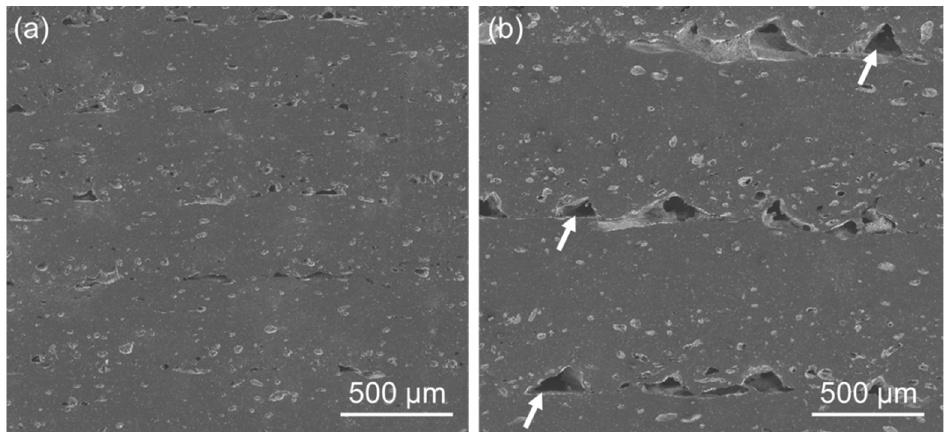
Figure 17. Cross sections of untested specimens printed with a layer height of ( a ) 0.2 mm (C14) and ( b ) 0.4 mm (C6). Gaps between beads seen in ( b ) are marked with arrows. Spots in light grey were voids that were filled with carbon during the sputtering prior to SEM.